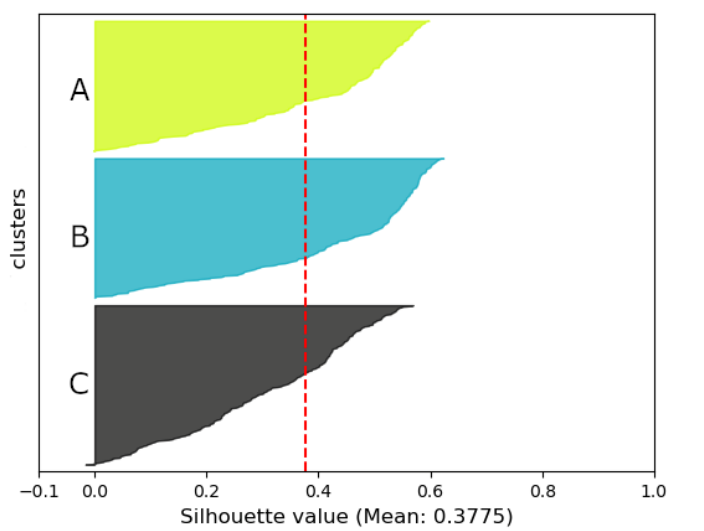
Figure 10. Silhouette graphic for case 5 showing the consistency for clusters A, B, and C.